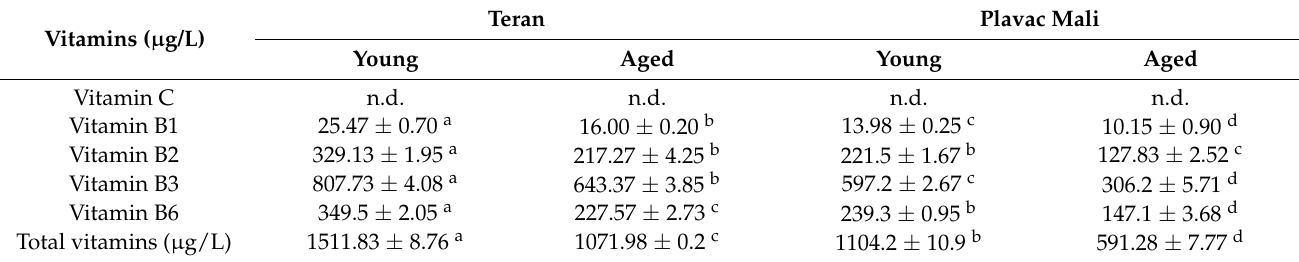
Table 8. Concentration ( µ g/L) of vitamins in young and aged Teran and Plavac mali